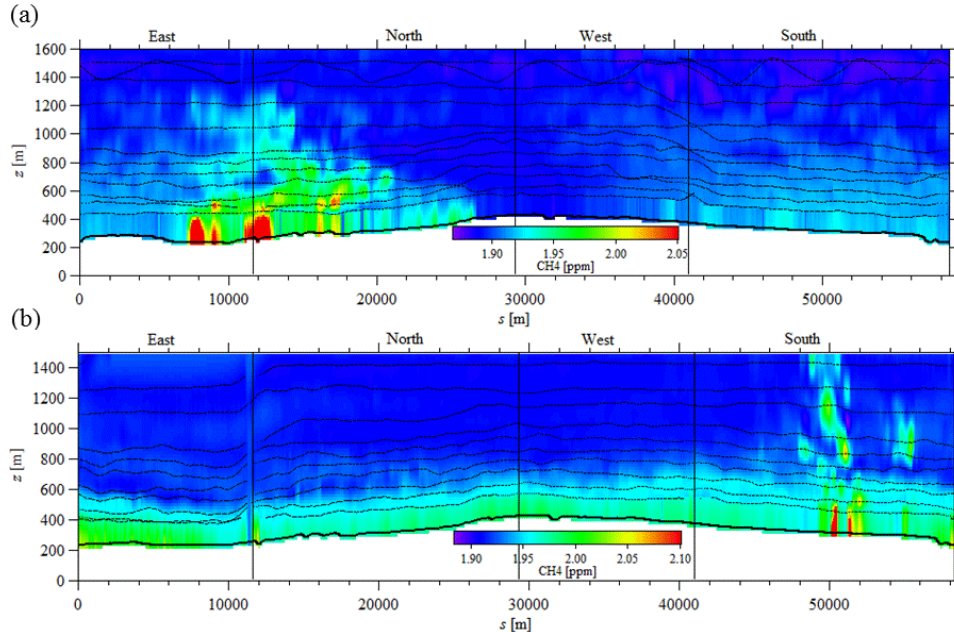
Figure 5. Kriging-interpolated CH 4 mixing ratios for the 20 August (a) and 2 September (b) flights. The flight path is superimposed (black dots). Values below the lowest flight path are extrapolated with an exponential fit (Eq.